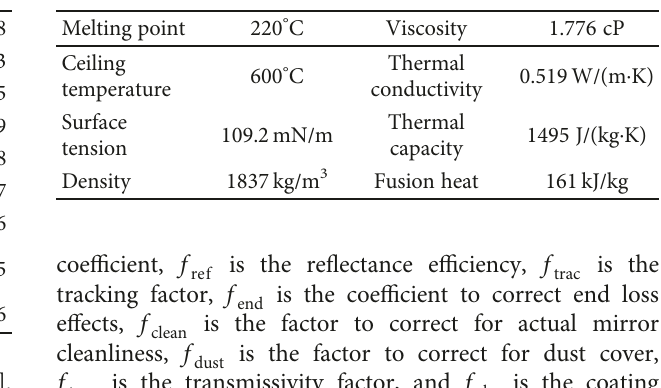
Table 3: Main parameters of CSP module. Table 4: Physical property of solar